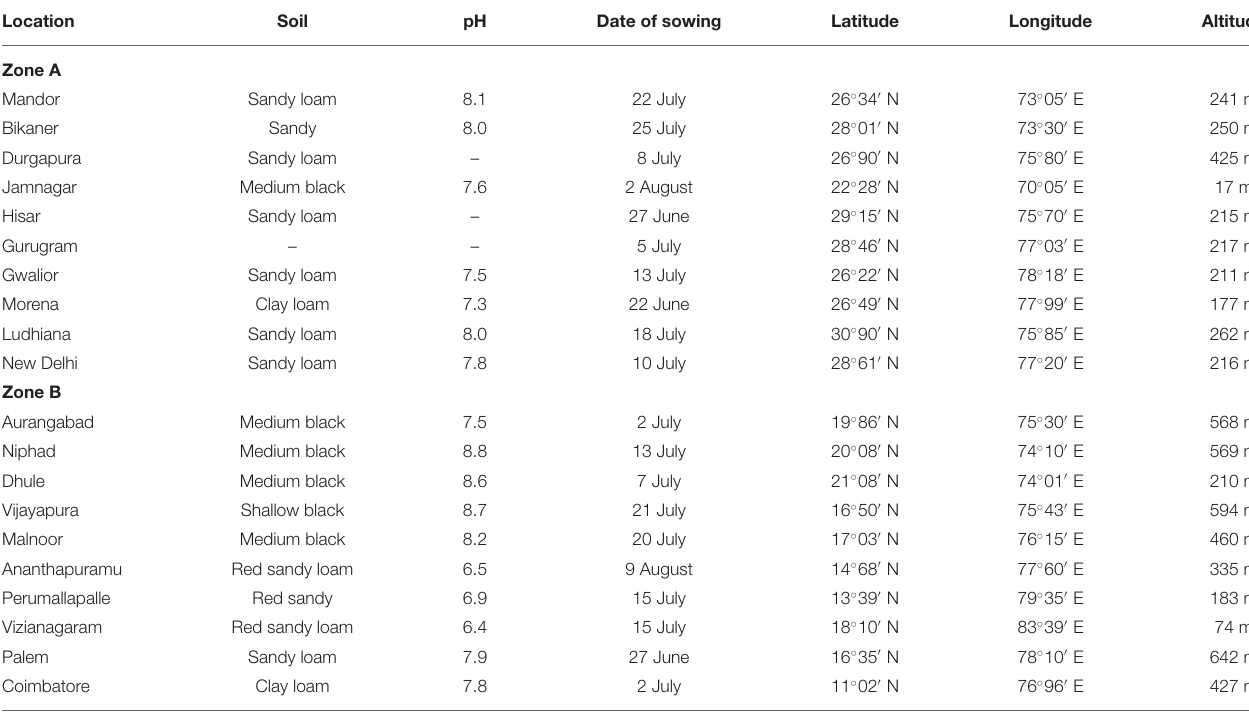
TABLE 2 | Test locations used in the study.